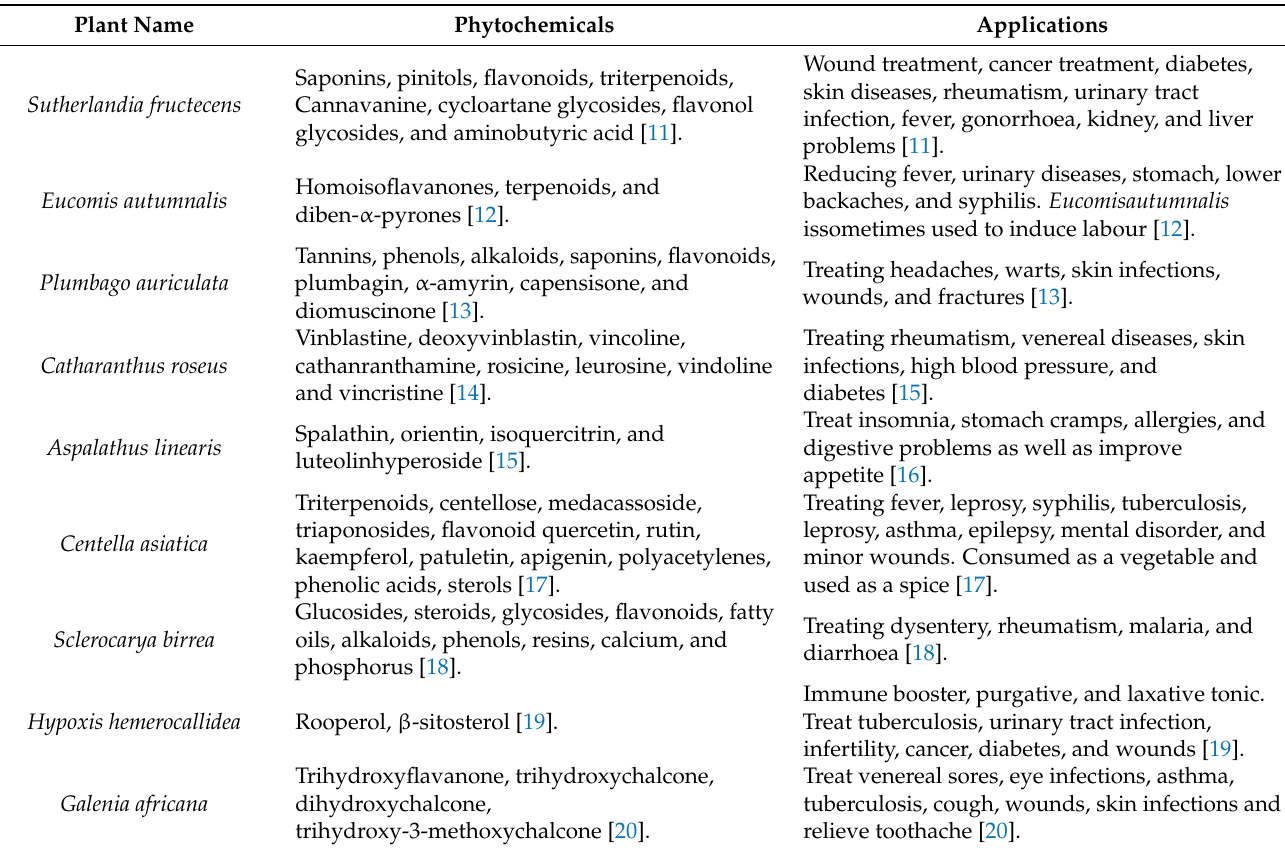
Table 1. Representation of medicinal plant extracts and their